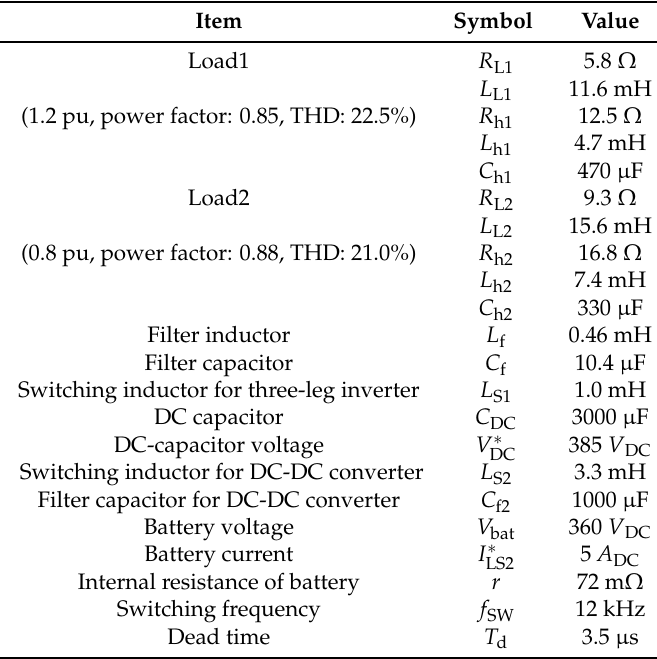
Table 1. Circuit constants for Figure